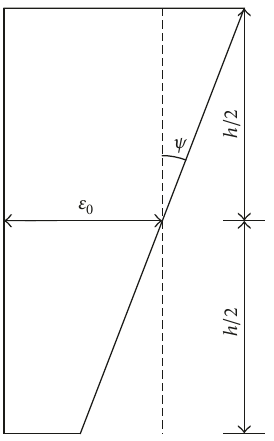
Figure 3: The final strain under the plane section